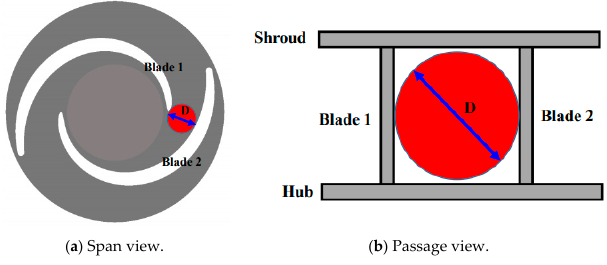
Figure 6. Definition of the waste solid volume.